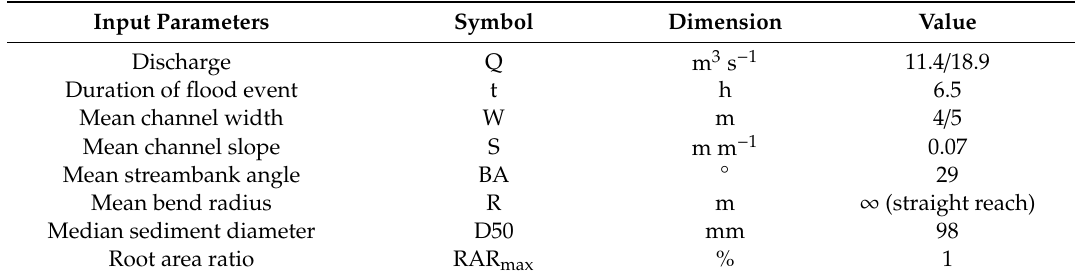
Table 5. Input parameters for the cross section at the Sulzigraben catchment in the Canton of Bern, Switzerland for the two erosion